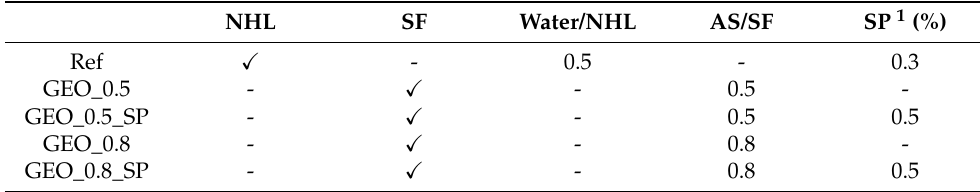
Table 2. Grout compositions applied in the study.